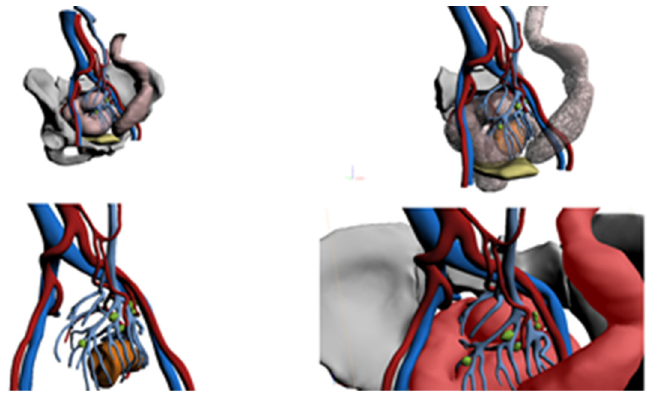
Figure 5. 3D reconstruction (Case 1).